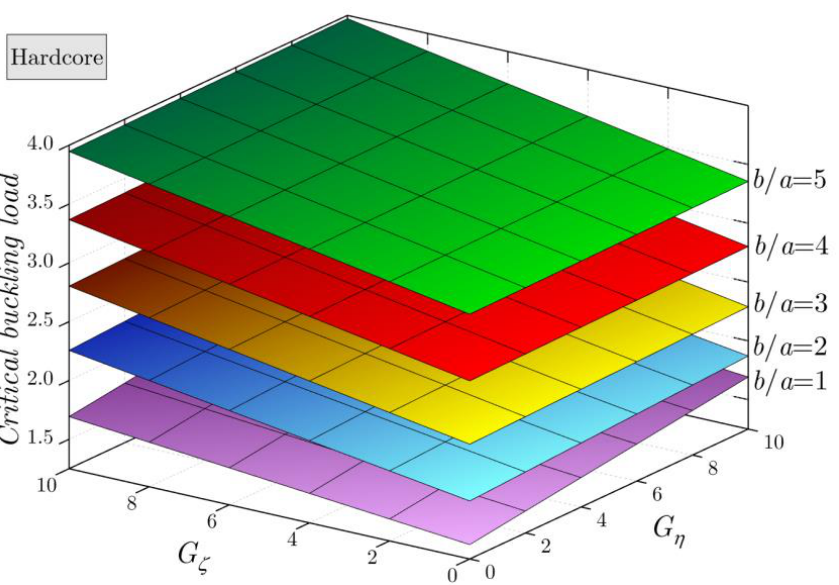
Figure 14. Effect of the orthotropic elastic foundation parameters G ζ and G η for various aspect ratios b / a ( FG − A , SSSS , R = 5, p = k = e = 2, a = 10 h , µ = λ = 0, θ = 0 ◦ , K w = 10 ) .